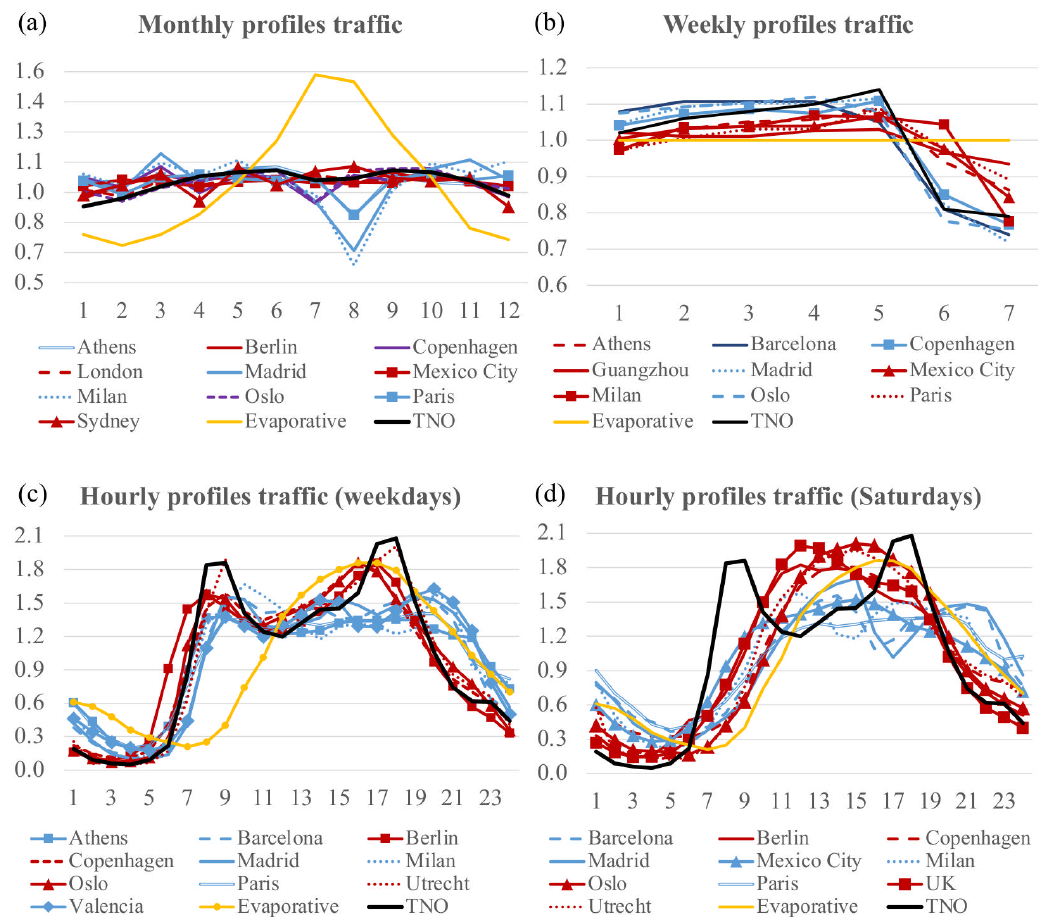
Figure 4. Monthly (a) , weekly (b) and hourly ( c , for weekdays, d for Saturdays) temporal profiles derived from measured traffic counts in selected cities (see Table 6 for references). The profile reported by the TNO dataset is plotted for comparison purposes (Denier van der Gon et al., 2011). The monthly, weekly and hourly profiles proposed for the gasoline evaporative emissions (Evaporative, yellow line) is also